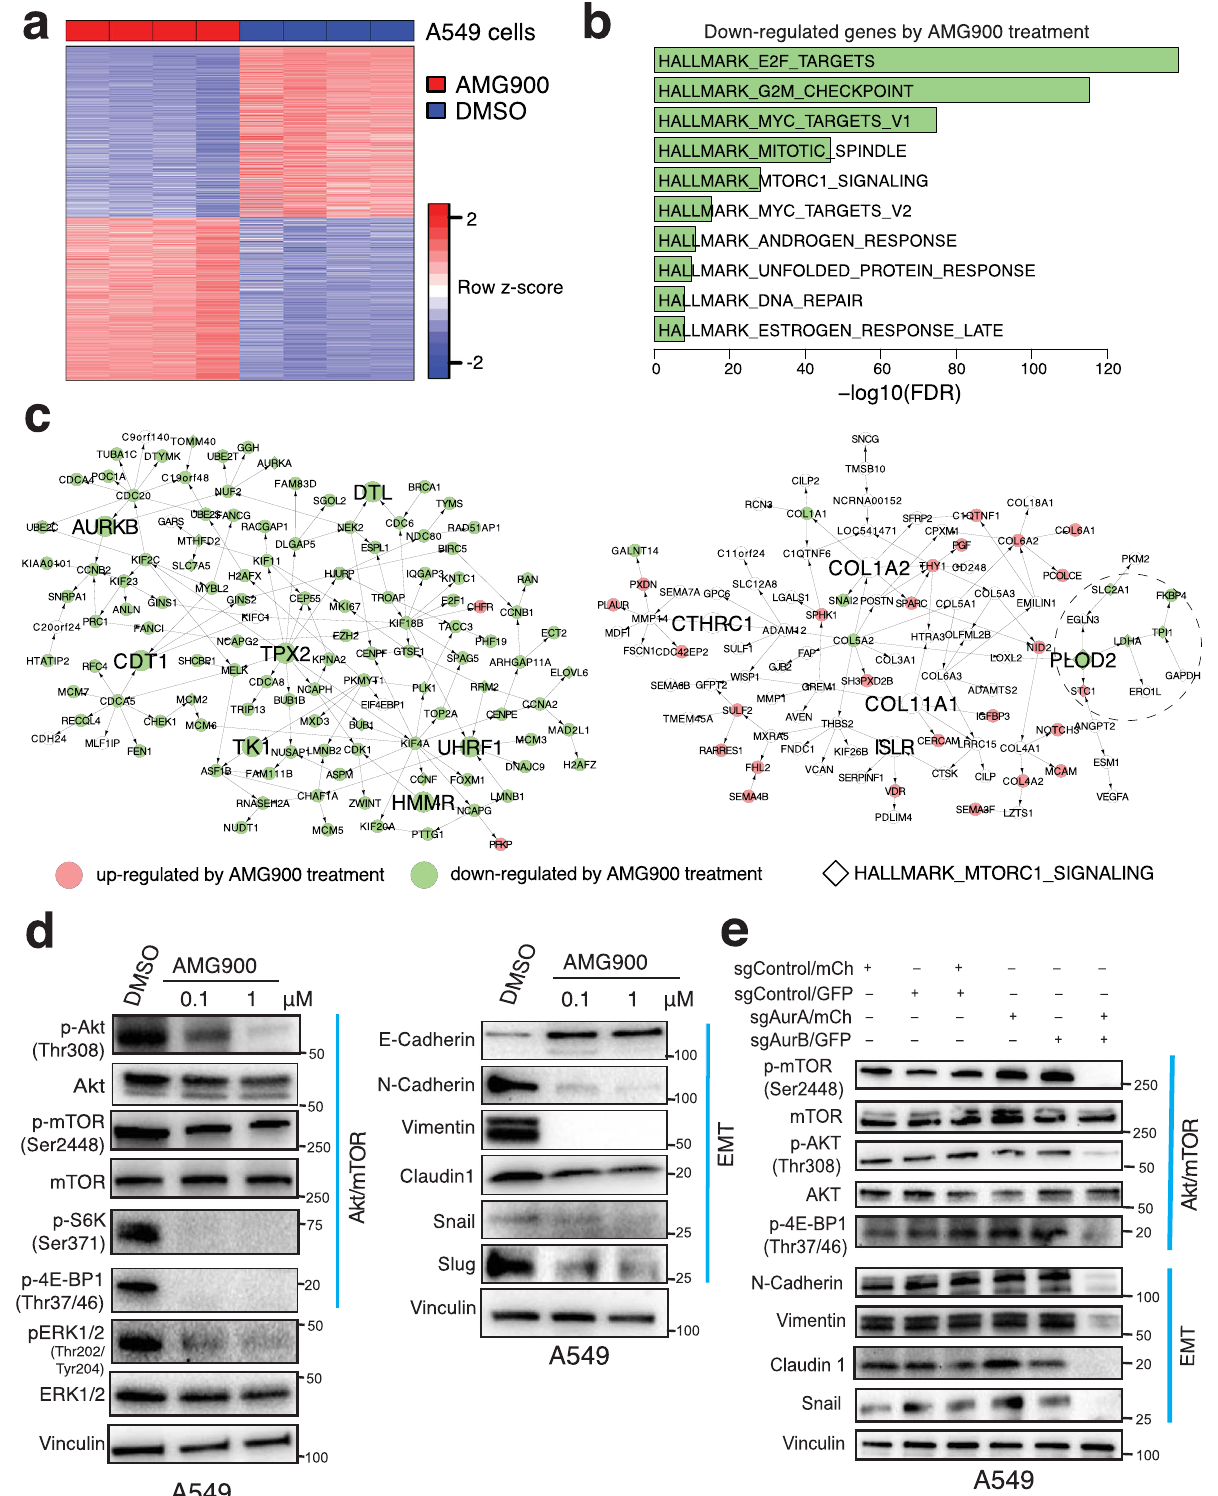
Fig. 5 Aurora kinases drive invasiveness in lung adenocarcinoma through activating AKT/mTOR and EMT pathways. a Differentially expressed genes between DMSO and 0.1 μ M AMG900 treated A549 cells (FDR < 0.01). DEGs are listed in Supplementary Data 4. b Top 10 downregulated HALLMARK pathways in A549 treated with 0.1 μ M AMG900. c Overlaying the DEGs in A549 cells onto the TPX2/AURKB and COL1A2 subnetworks. Nodes fi lled in red are upregulated and ones in green are downregulated by AMG900 treatment. Genes included in HALLMARK_MTORC1_SIGLANING pathways are indicated with diamonds ( ◊ ) within a dashed circle. d Western blot for A549 cells treated with DMSO and indicated concentrations of AMG900 for 48 h for AKT/mTOR pathway and EMT pathway. Source data are provided in Source Data fi les. e Western blots of markers of AKT/mTOR and EMT pathways in A549 cells treated with indicated sgRNAs. Source data are provided in Source Data fi